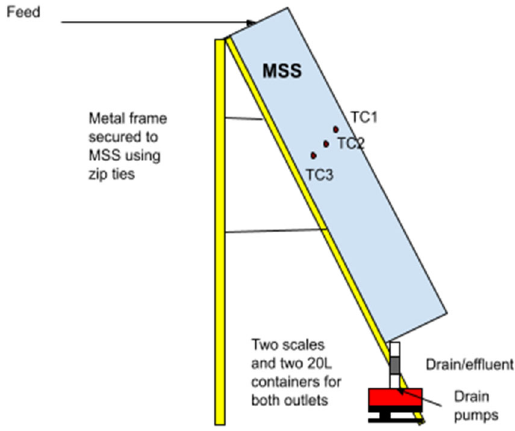
Figure 6. Prototype setup side view with a 55 ◦ tilt.